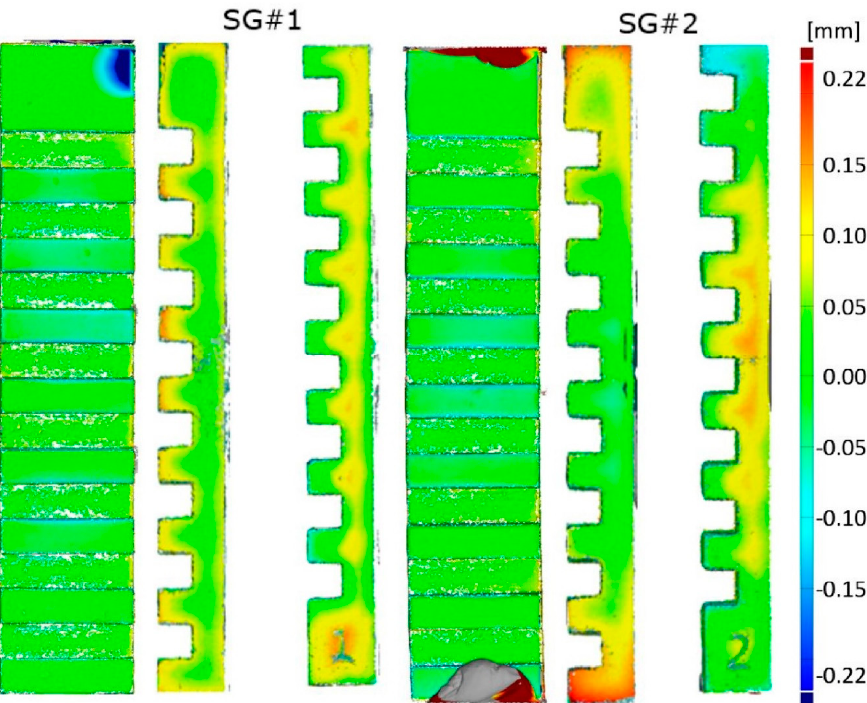
Figure 16. 3D distance color map comparisons between the acquired meshes and the CAD model. Different colors, as reported in the colored map, indicate the range of deviations.